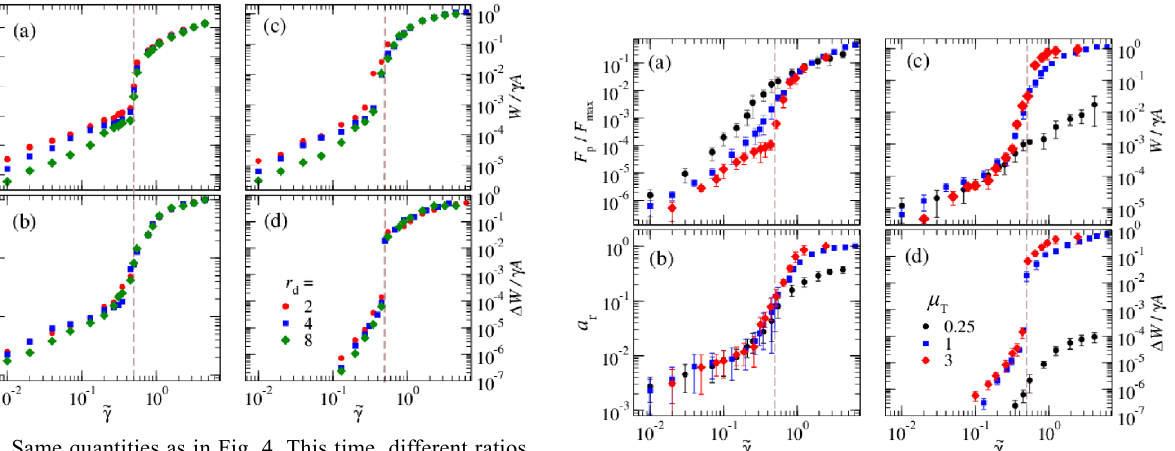
Fig. 6 Same quantities as in Fig. 4. Here, different Tabor parameter μ are considered with fixed T